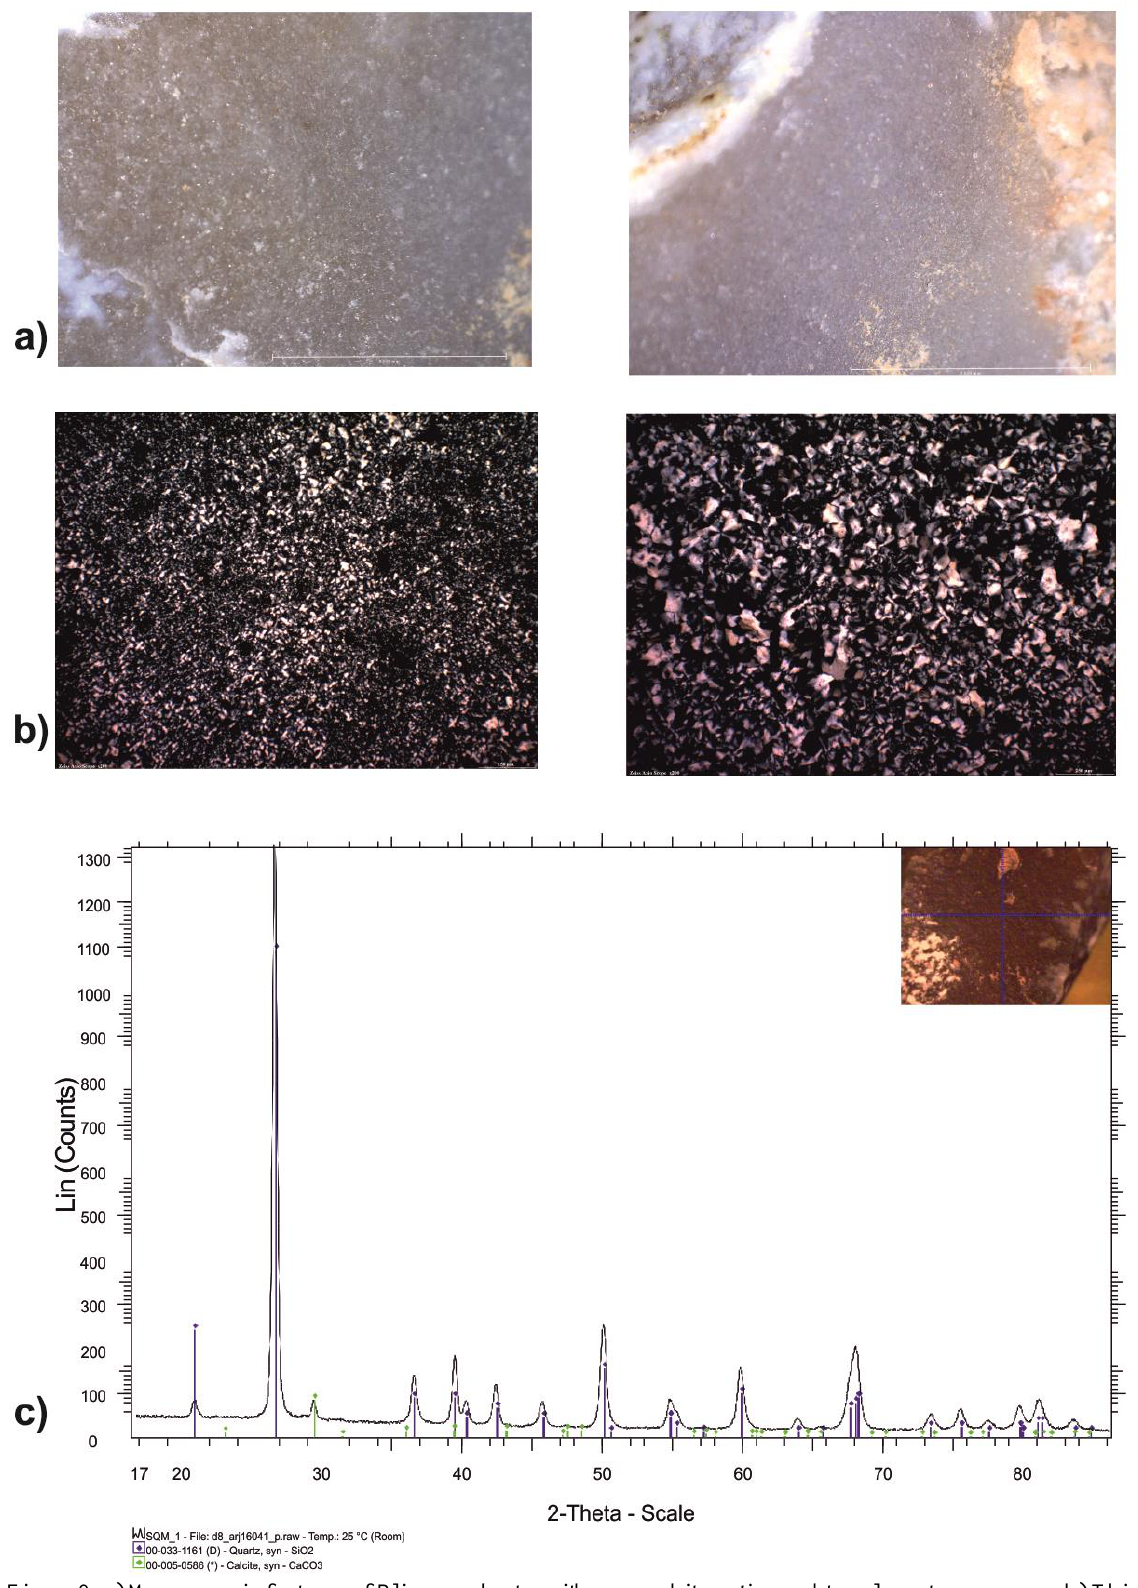
Figure 9. a) Macroscopic features of Pliocene cherts, with some white patina and translucent appearance. b) Thin sections show macroquartz, microquartz and length-fast chalcedony. c) μ-XRD confirms the presence of quartz and